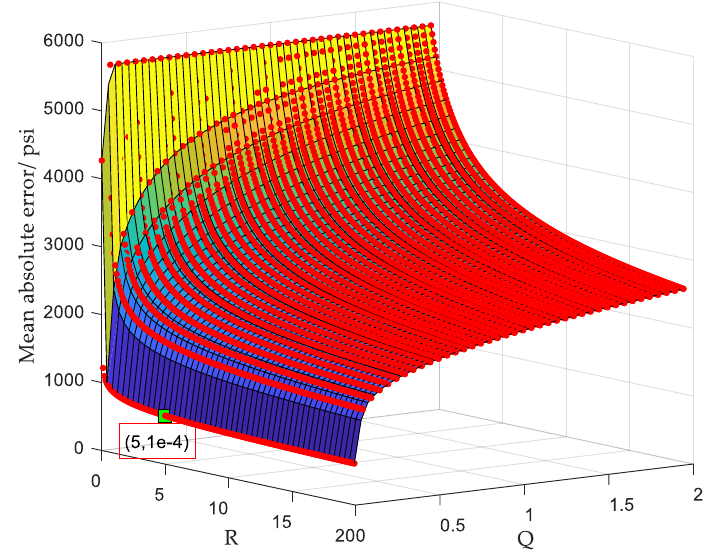
Figure 12. Distribution of mean absolute error under traversing Q and R.